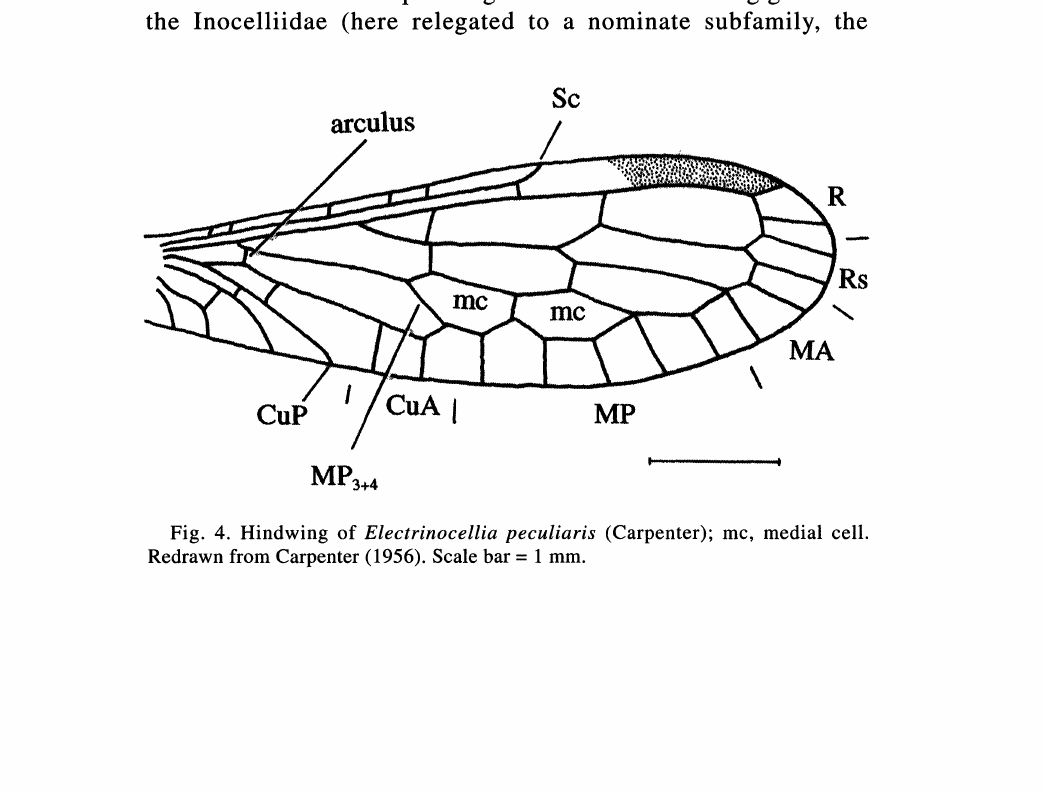
Fig. 4. Hindwing of Electrinocellia peculiaris (Carpenter); mc, medial cell. Redrawn from Carpenter (1956). Scale bar